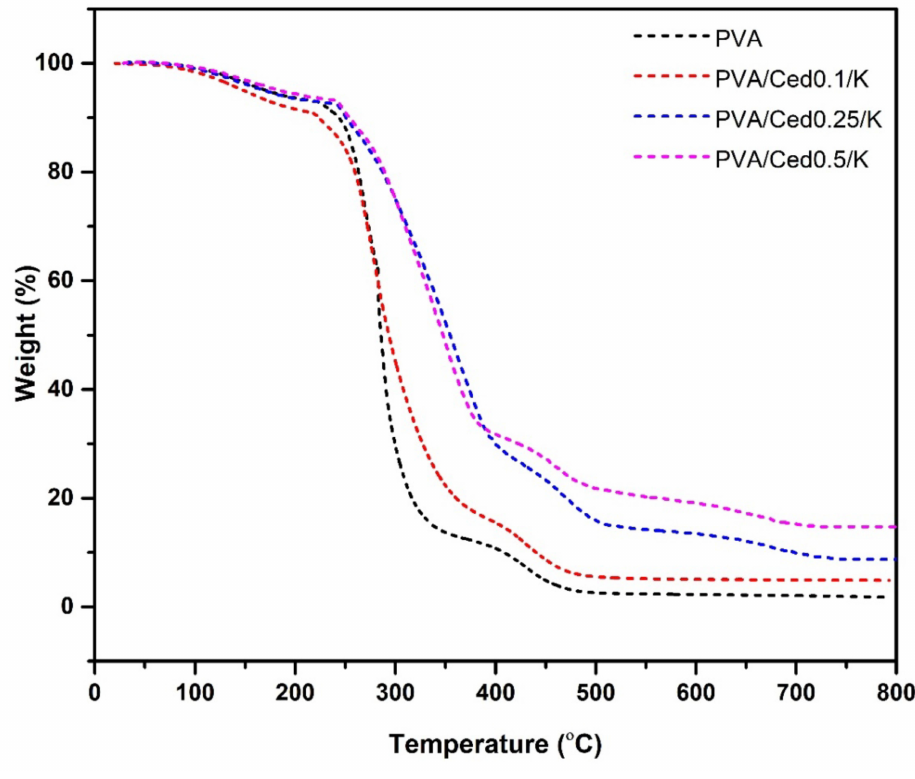
Figure 5. TGA analyses of PVA/Ced/K composite